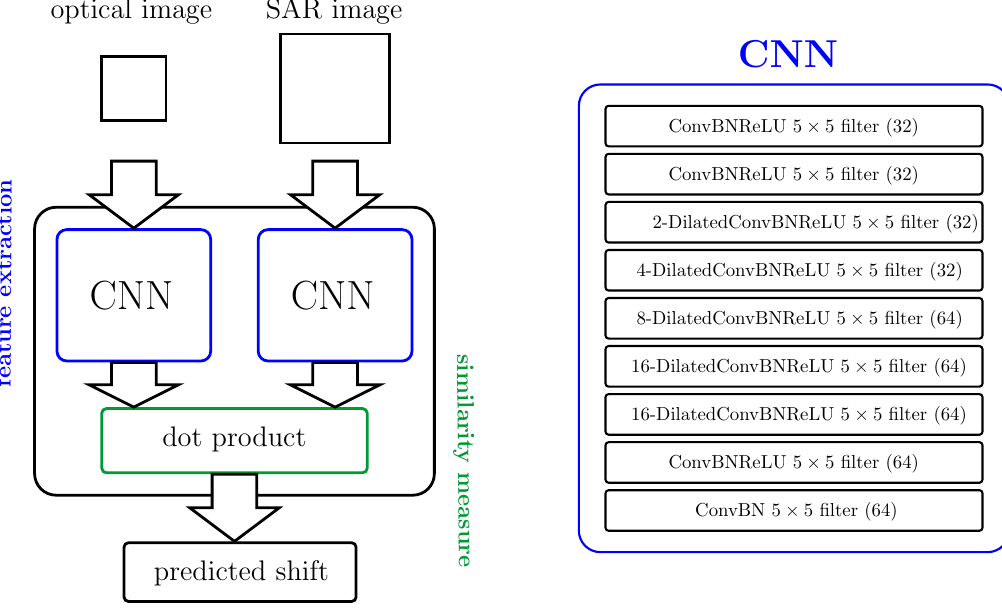
Figure 2. Network architecture ( left ) and a detailed overview of the convolutional layers ( right ). Abbreviations: convolutional neural network (CNN), convolution (Conv), batch normalization (BN) and rectified linear unit